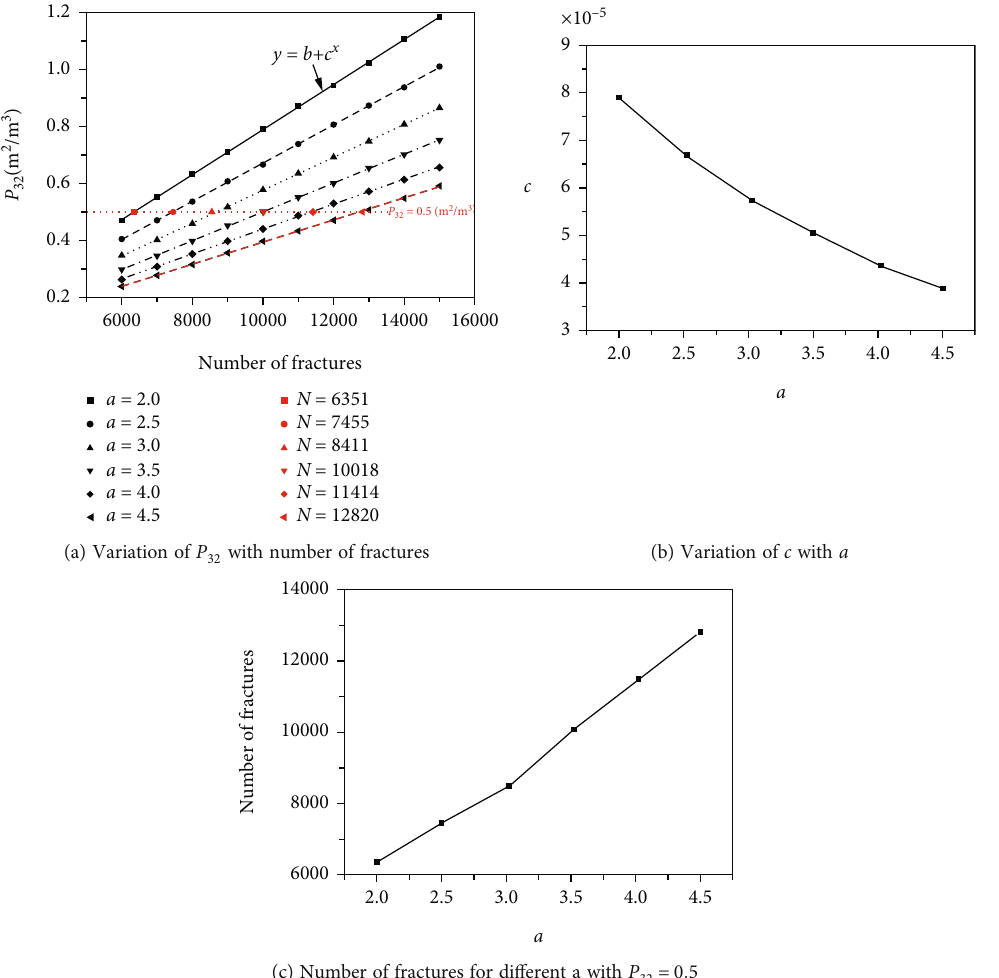
and number of fractures for di ff erent a . 32